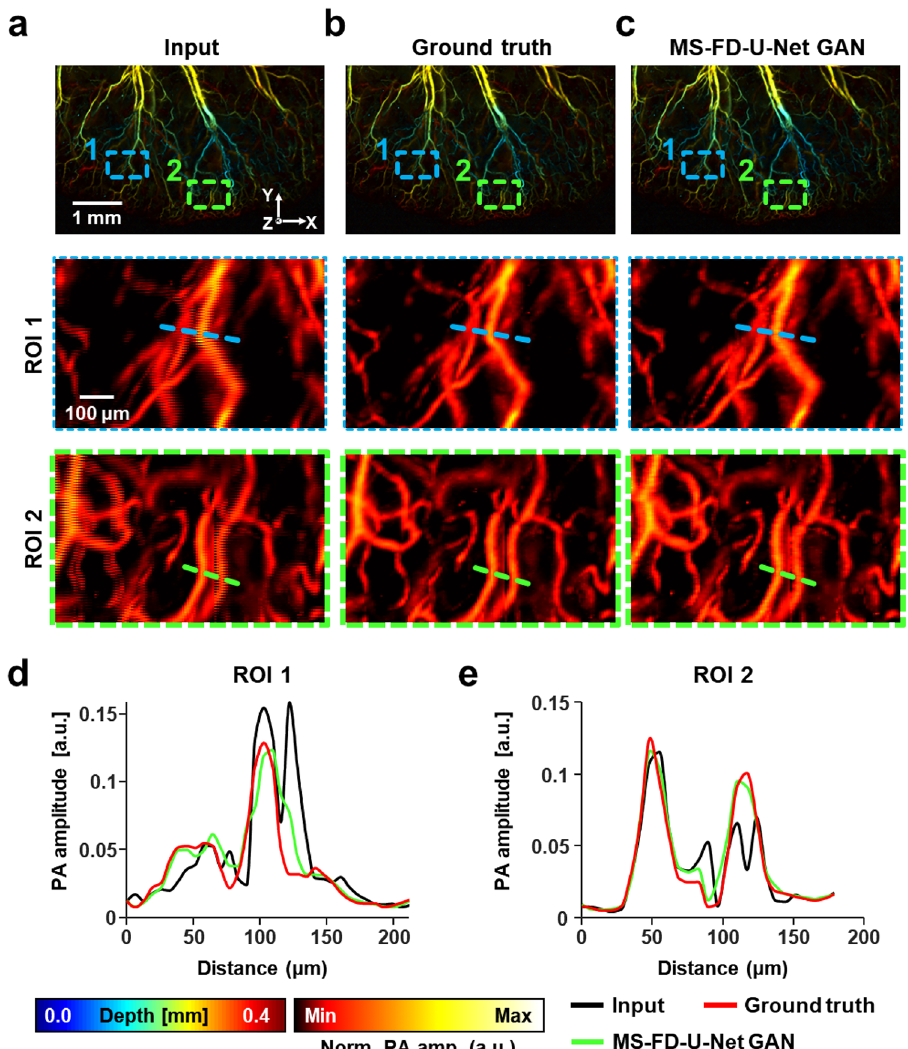
Figure 4. Extrapolation application of MS-FD-U-Net. ( a – c ) Depth-encoded PA images of a mouse’s ear reconstructed with ( a ) bidirectionally (marked as Input) and ( b ) unidirectionally (marked as Ground truth) acquired data, ( c ) the MS-FD-U-Net GAN. Close-up PA MAP views of ROI 1 and 2 in the regions indicated by the blue and green boxes are presented, respectively. PA amplitude profiles indicated by the dotted lines in ( d ) ROI 1 and ( e ) ROI 2, respectively. MAP, maximum amplitude projection; ROI, region of interest; and Norm. PA amp., normalized PA